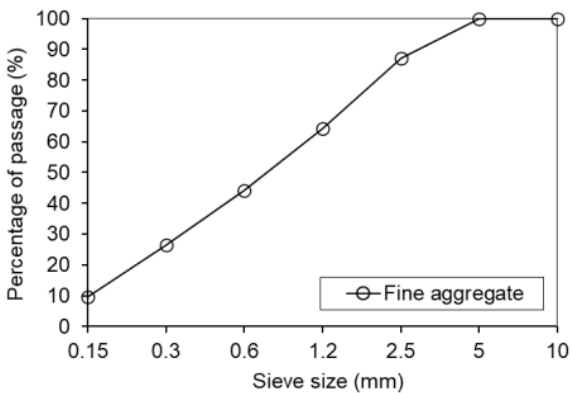
Figure 1. P article size distribution of fine